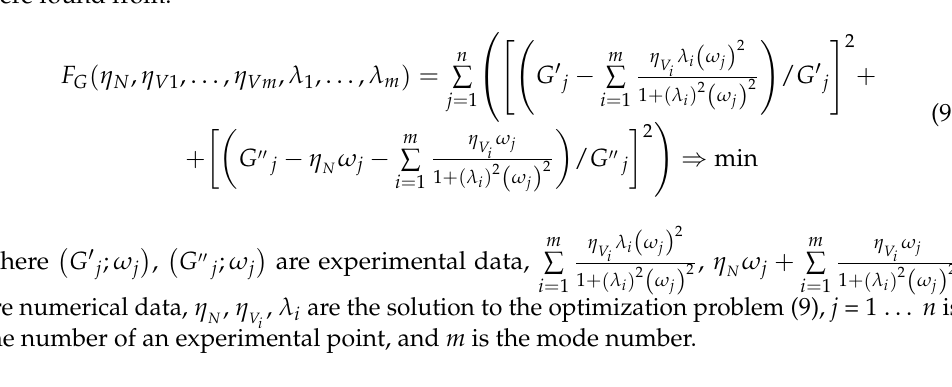
Table 1. Parameters of Giesekus